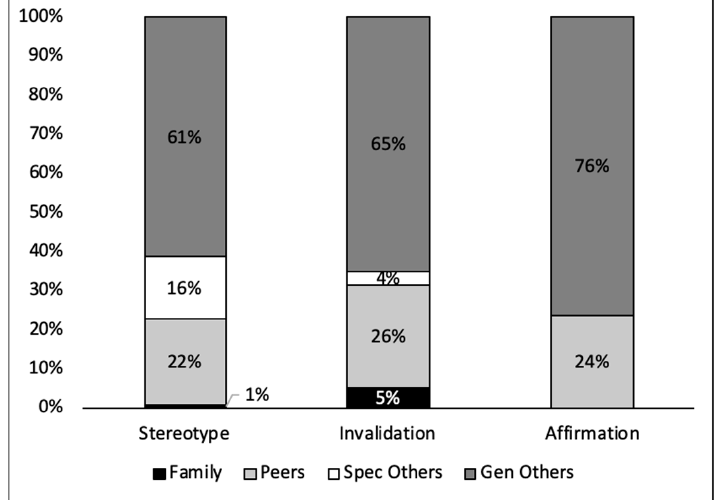
Figure 2. Distribution of messages attributed to each Message Source for each Message Type. Spec Others = Specific Others; Gen Others = General Others